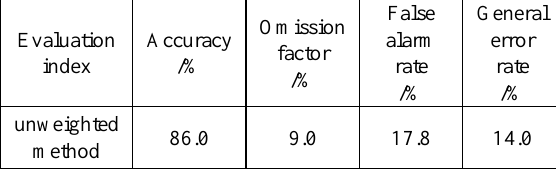
Table 1. The precision evaluation of change detection results based on the polarimetric scattering